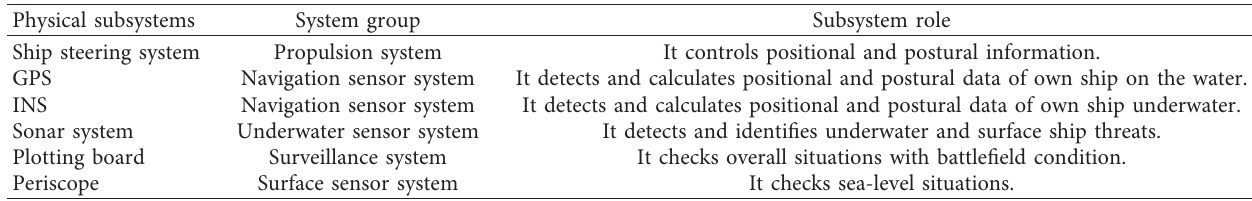
Table 2: Physical subsystems targeted in this